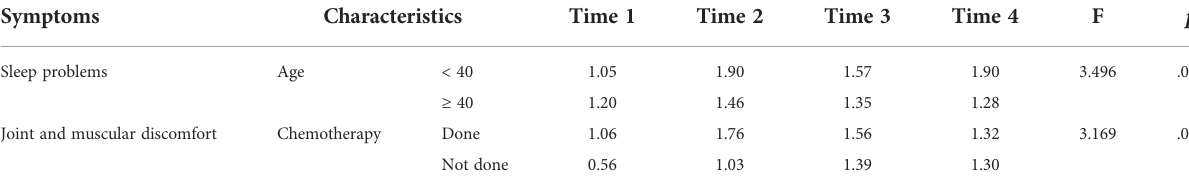
TABLE 3 Interaction effects of participant characteristics on patient-reported menopausal symptoms over four time